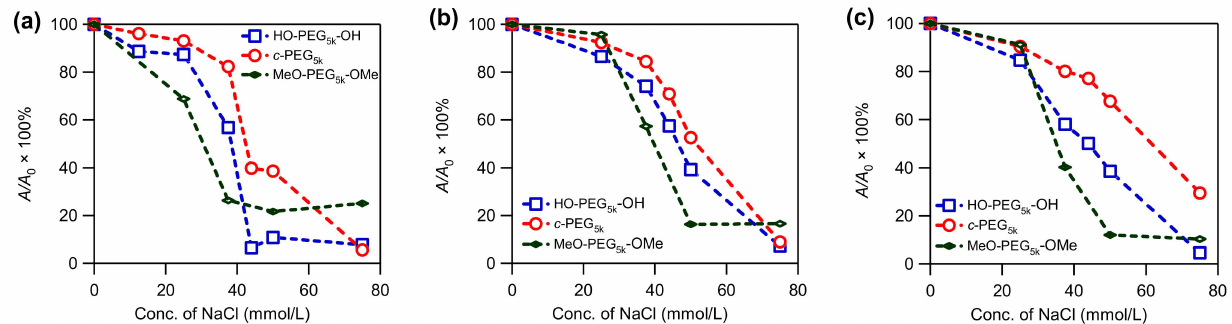
Figure 3. Plots of relative UV–Vis absorption intensity ( A/A 0 × 100%) at λ max versus the NaCl concentration for AgNPs prepared in the presence of HO–PEG 5k –OH (blue), c -PEG 5k (red), and MeO–PEG 5k –OMe (green) at ( a ) ω = 2.2, ( b ) ω = 11, and ( c ) ω = 44.